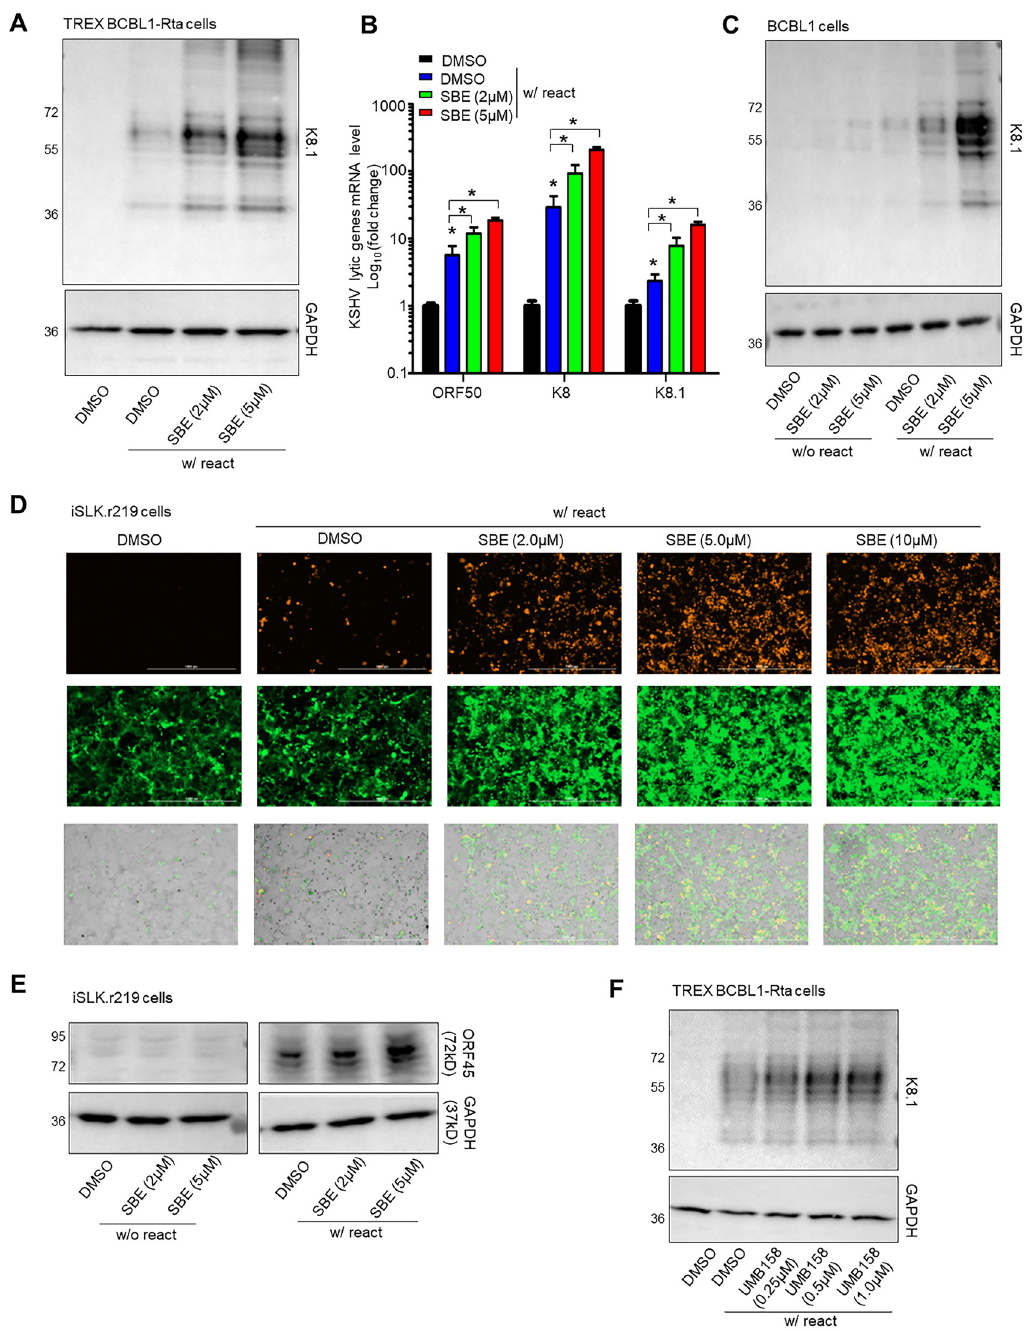
Fig 2. PLK1 inhibition facilitates lytic switch of latent KSHV. (A) TREx BCBL1-Rta cells were treated with the PLK1-specific inhibitor, SBE 13 HCl (SBE), and Dox to induce KSHV reactivation. Protein level of KSHV K8.1 was measured by immunoblotting. GAPDH was used as a loading control. (B) mRNA level of KSHV lytic genes (ORF50, K8, K8.1) in above cells (A) were measured by RT-qPCR and normalized to GAPDH. Results were calculated from n = 3 independent experiments and presented as mean ± SD ( � p < 0.05, treatment vs DMSO only and as specified; two-way ANOVA). (C) BCBL1 cells were treated with SBE or DMSO, in the presence or absence of TPA (20ng/ml) + sodium butyrate (TPA/NaB) (1mM) to induce KSHV reactivation. Protein level of KSHV K8.1 was measured by immunoblotting. GAPDH was used as loading control. (D) iSLK.r219 cells were treated with SBE or DMSO, and Dox to induced KSHV reactivation. GFP and RFP signals in these cells were visualized by fluorescence microscopy. (E) Protein level of KSHV lytic gene ORF45 in iSLK.r219 cells +/- SBE and +/- Dox was measured by immunoblotting. GAPDH was used as a loading control. (F) TREx BCBL1-Rta cells were treated with the PLK1/BET dual inhibitor, UMB-158, and Dox to induce KSHV reactivation. Protein level of KSHV K8.1 was measured by immunoblotting. GAPDH was used as a loading control. https://doi.org/10.1371/journal.ppat.1009764.g002 PLOS Pathogens| https://doi.org/10.1371/journal.ppat.1009764 July 23,